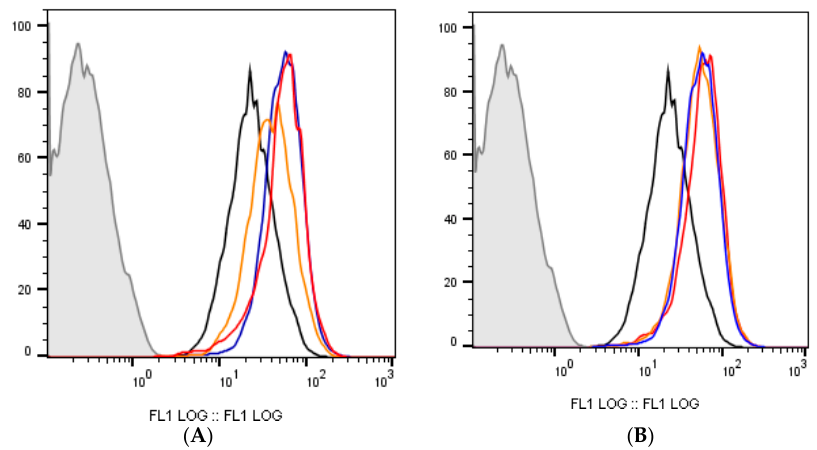
Figure 15. Cell fluorescence due to CFSE staining. In all graphs, the black line indicates control (stained), the grey line indicates unstained control and the blue line represents 5-FU. ( A ) The red line indicates the combination of 5-FU + verapamil and the orange line indicates verapamil. ( B ) Red and orange lines represent 5-FU + itraconazole and itraconazole, respectively. orange lines represent 5-FU + itraconazole and itraconazole, respectively.